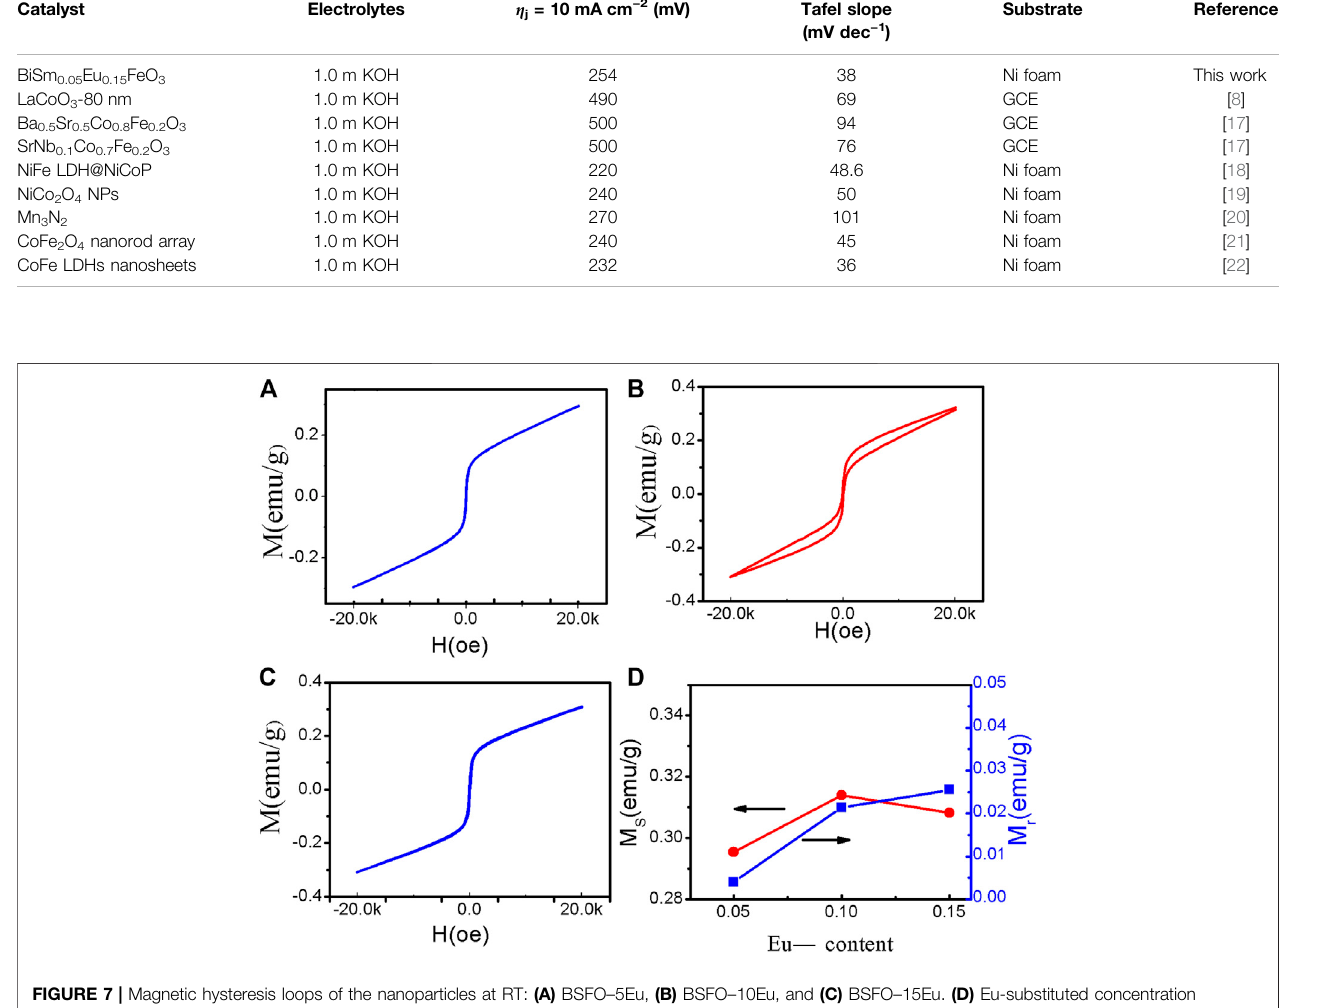
TABLE 3 | Comparison of OER activity for different. Catalyst